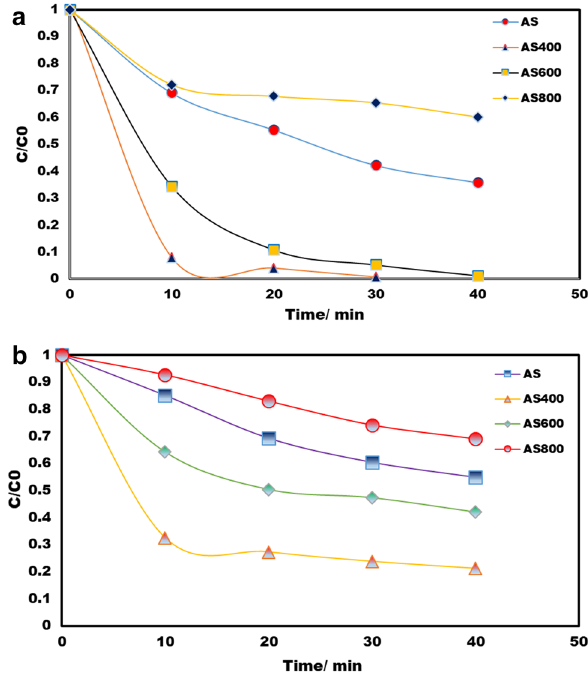
Fig. 4 Effect of alum sludge calcined temperature on a LFR (Dye 100 mg/L; H2O2 800 mg/L; AS400 1 g/L; pH 3.0) and b LA (Dye o 50 mg/L; H2O2 800 mg/L; AS400 1 g/L; pH 3.0) azo-dyes removafl during oxidation for different time ( t